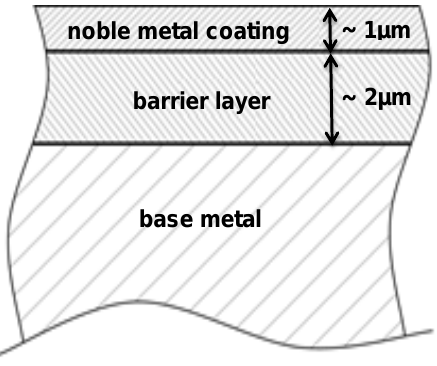
Figure 2. Cross-section of plating system of electrical contacts before the wear and fretting corrosion test.